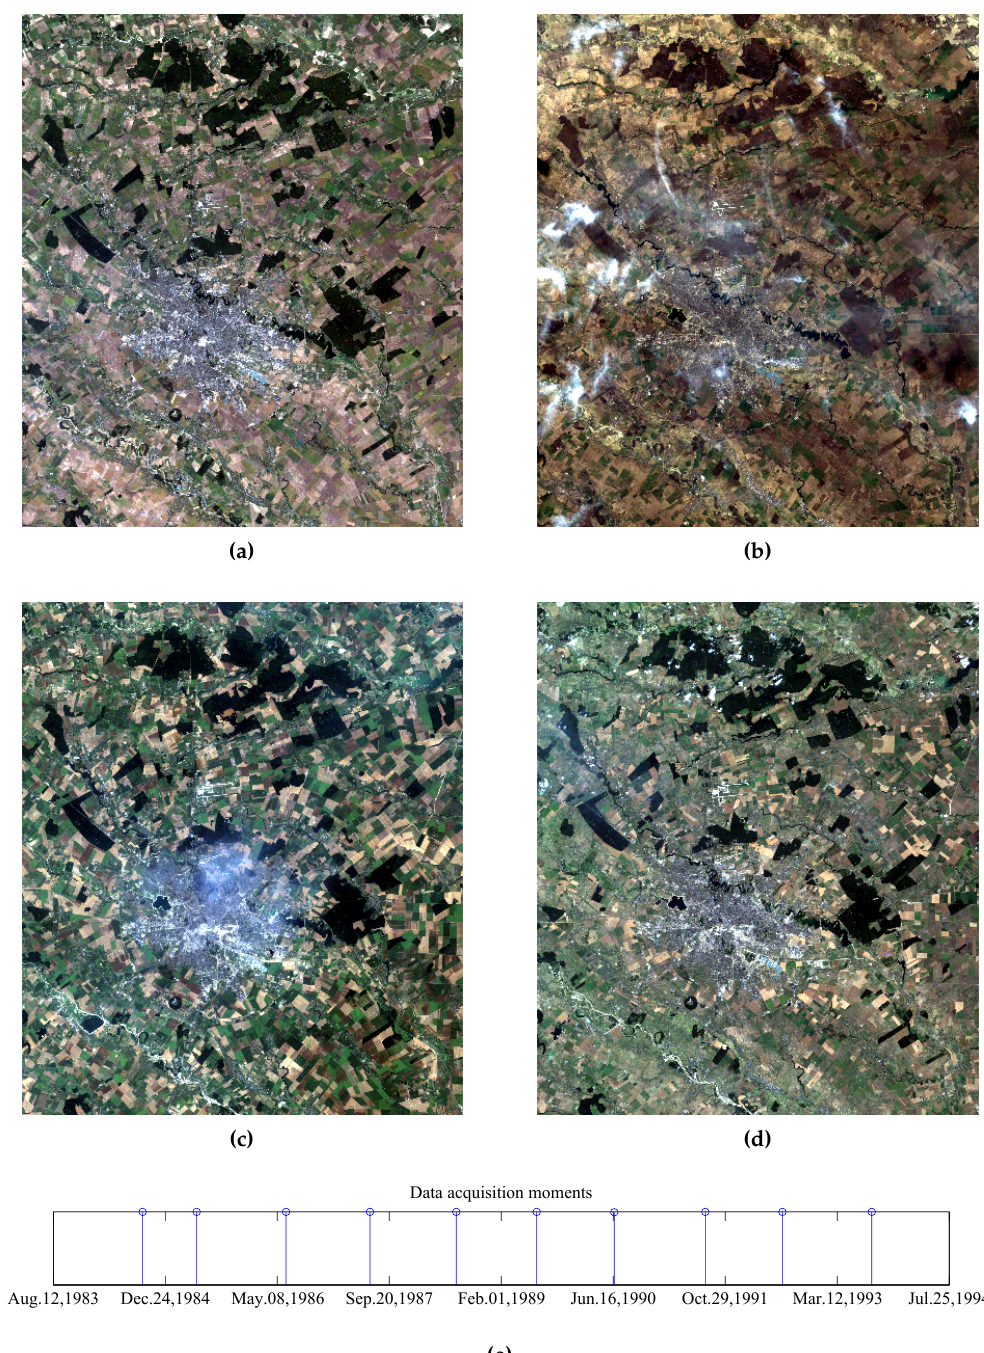
Figure 4. Short Landsat SITS comprised of 10 images captured between 1984–1993. Only four representative images (i.e., containing specific changes) of the series are shown: ( a ) 1984, ( b ) 1987, ( c ) 1988, ( d ) 1992. The distribution of the acquisition moments is shown in ( e